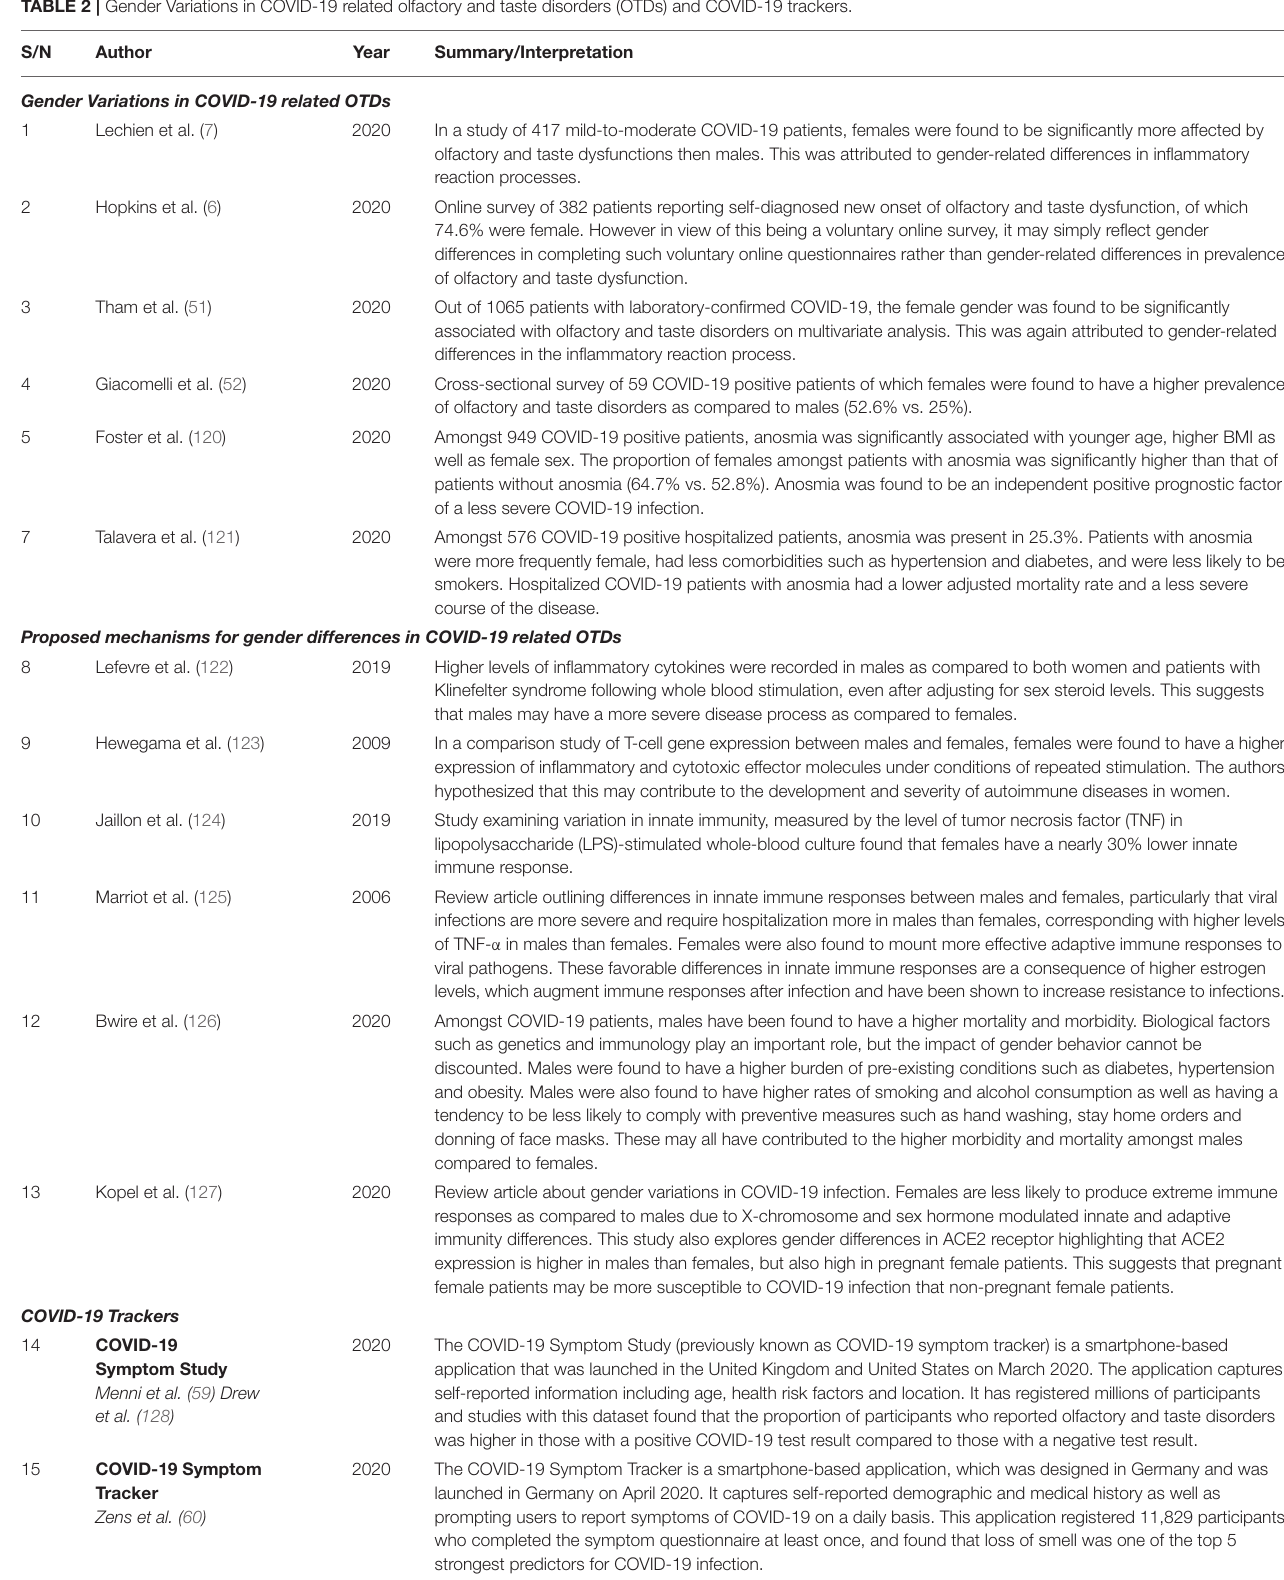
TABLE 2 | Gender Variations in COVID-19 related olfactory and taste disorders (OTDs) and COVID-19